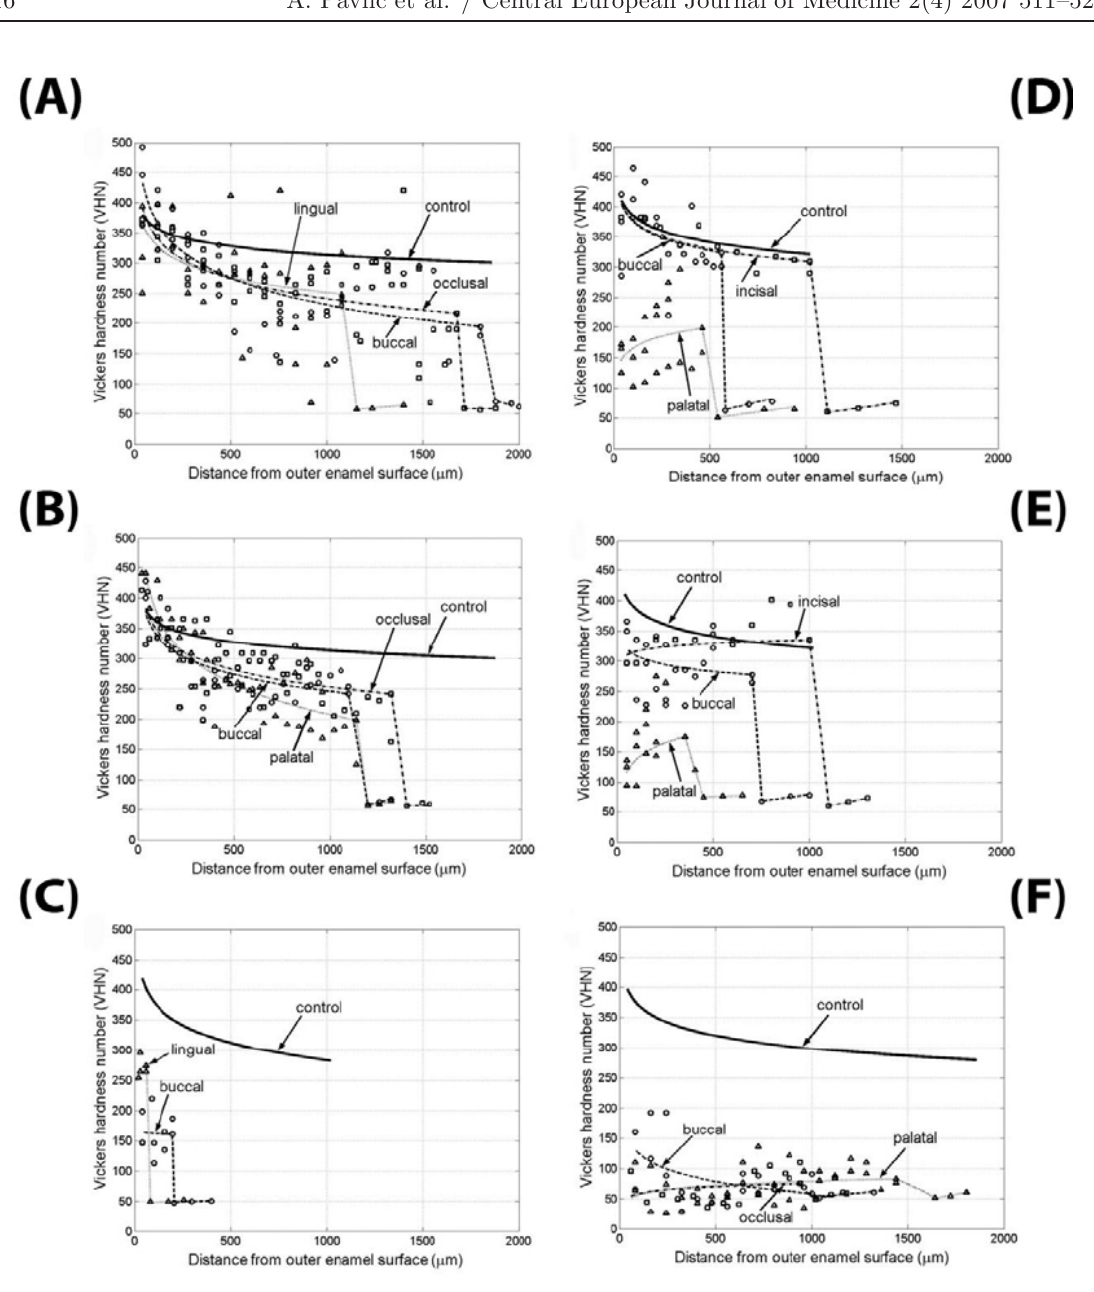
Fig.2 Microhardness values and profiles of each AI sample are presented on individual graphs. The individual microhardness measurements are represented as triangles for the palatal/lingual surface, circles for the buccal surface, and squares for the incisal/occlusal surface. Each graph contains three logarithmic curves representing measurements on the three different AI tooth surfaces: palatal/lingual ( •••• ), buccal (- - -), and incisal/occlusal (- • -). The length of this curve also represents the thickness of the enamel on that partic- ular surface. A sudden drop in values, represented by an almost vertical line, indicates the DEJ, whereas the last three values, fitted to a line, represent measurements made in dentin. For comparative purposes, the fitted logarithmic curve of microhardness measure- ments of the corresponding healthy control tooth, taken from multiple measurements of the palatal/lingual, buccal, and incisal/occlusal surfaces, is drawn as a solid line. (A,